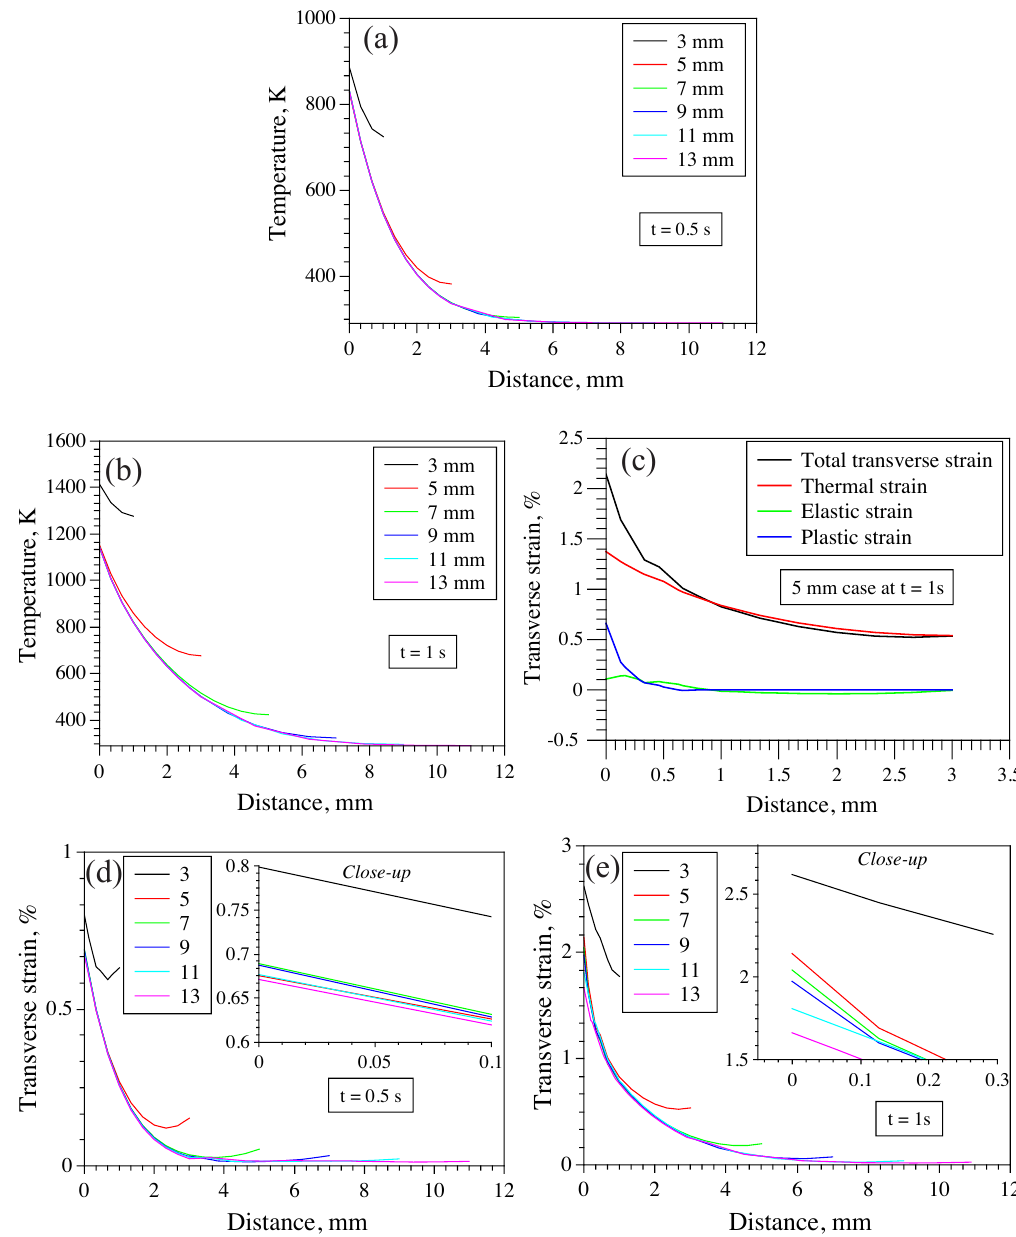
Figure 12. ( a ) simulated temperature field along L1 at t = 0.5s for different cases, ( b ) simulated temperature field along L1 at t = 1s for different cases, ( c ), simulated strain contributions and total strain for the 5mm case, ( d ) simulated transverse strain (in %) along L1 for different cases at t = 0.5s and ( e ) simulated transverse strain (in %) along L1 for different cases at t =